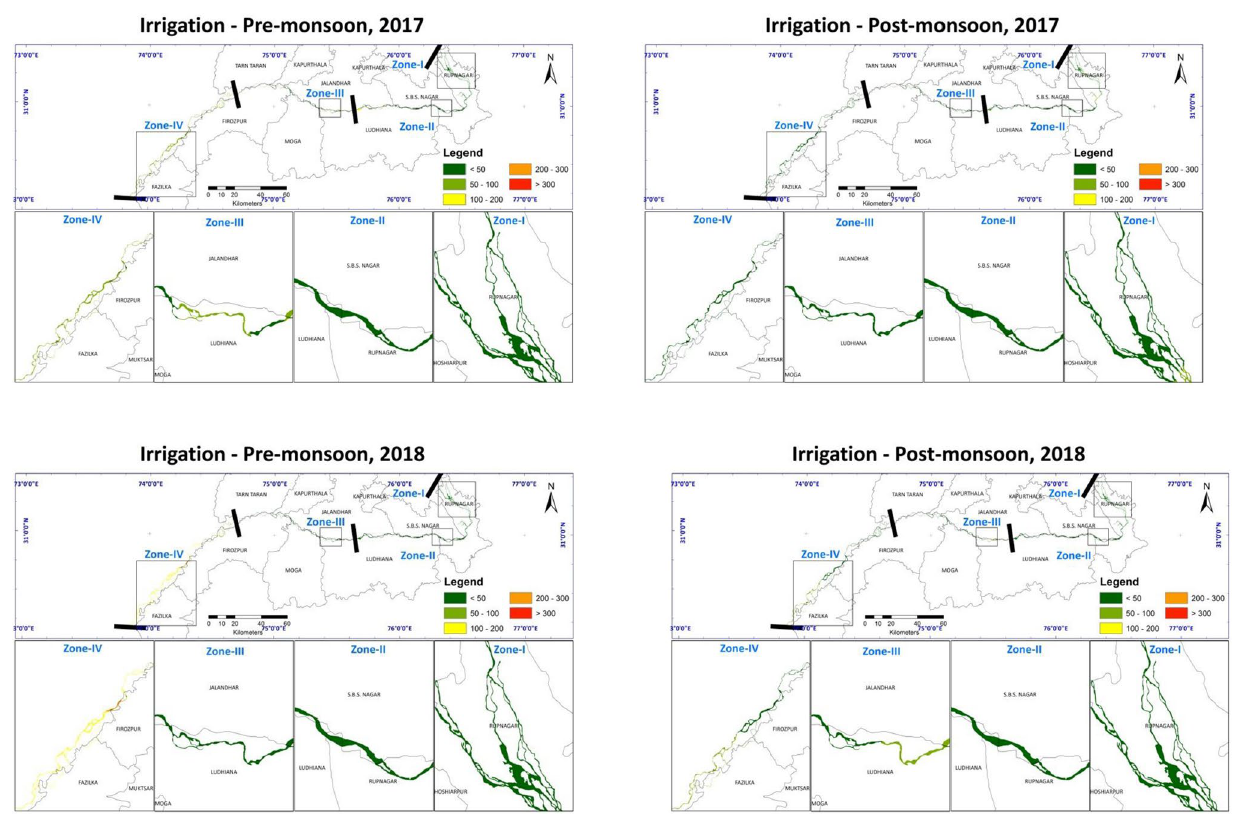
Fig. 3 Spatio-temporal variations in water quality index (for irrigation purposes) of water samples collected from the Sutlej